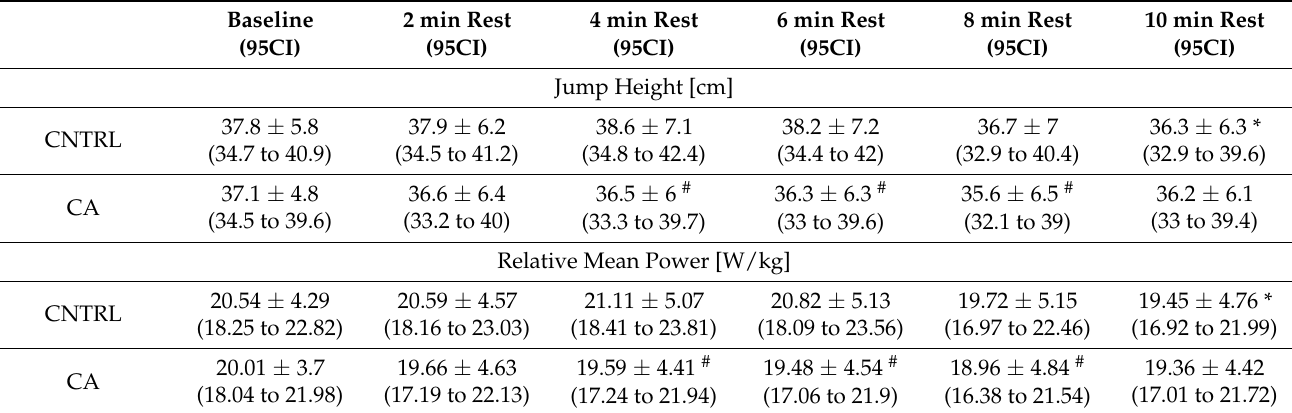
Table 2. Comparison of countermovement jump performance between two